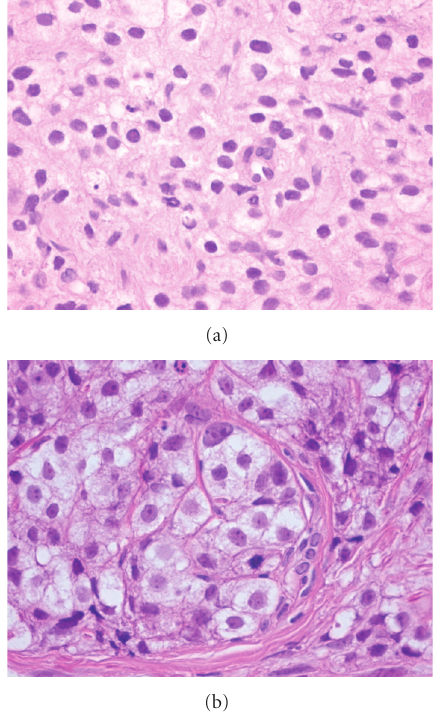
Figure 2: Haematoxylin-eosin stain of a poorly di ff erentiated tum- our from the prostate (a) and the pathological penile specimen (b).